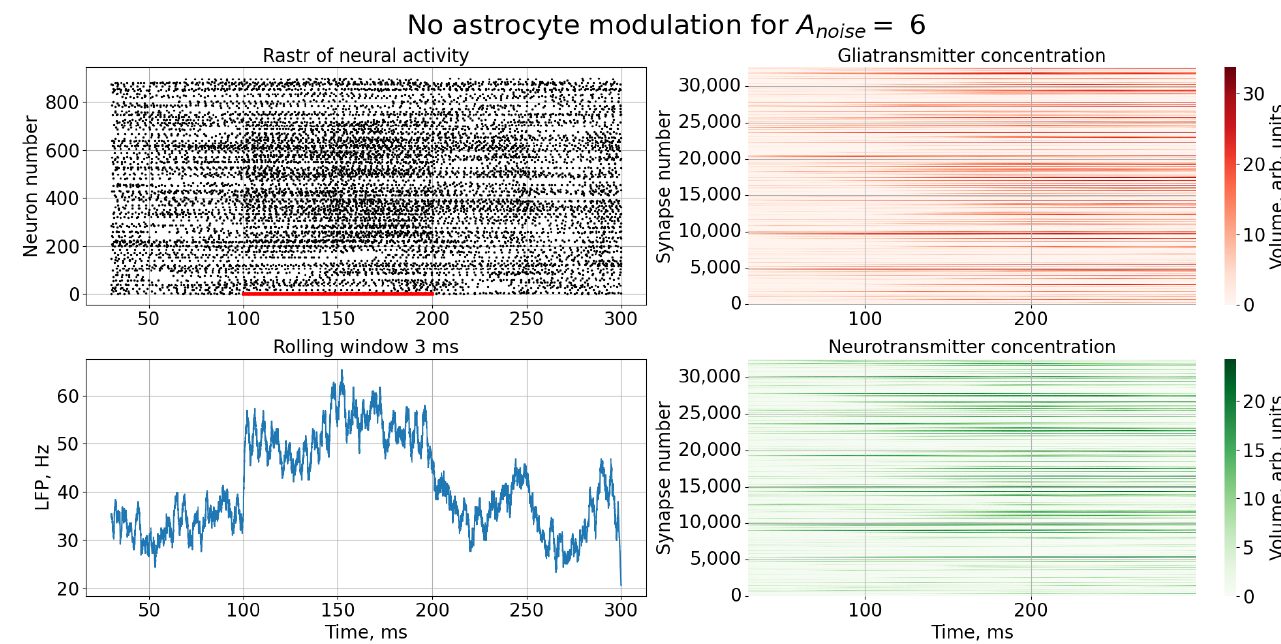
Figure 3. Time series of neural activity (upper left figure in the form of a raster diagram), the corre- sponding LFP signal with rolling window 3 ms (lower left figure) and time series of concentrations gliotransmitters (upper right figure) and concentration neurotransmitters (lower right figure) in the case of an external noise signal with A noise = 6 without astrocytic modulation.